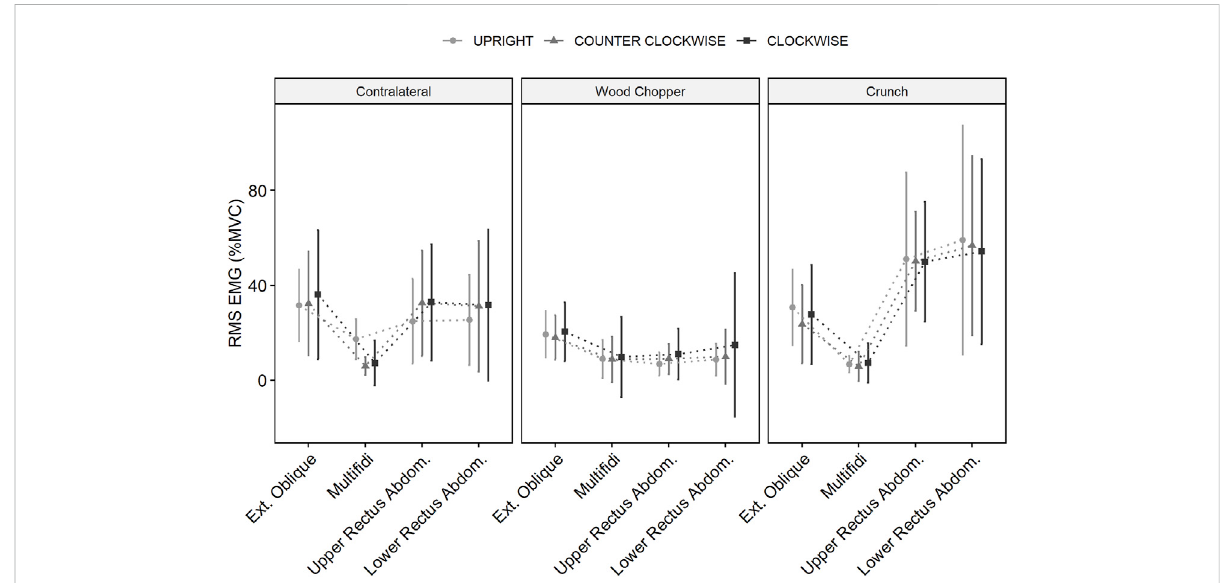
FIGURE 3 Root mean square of muscle activation (%MVC) for, External Oblique, Multi fi di, Upper and Lower Rectus Abdominis during exercises (Contralateral, Wood Chopper and Crunch), when standing upright (UPRIGHT) and during short arm human centrifugation (SAHC) when rotated clockwise (CLOCKWISE and counter-clockwise (COUNTER-CLOCKWISE) when supine with 1 g at the participant ’ s center of mass. Data as mean (±SD).